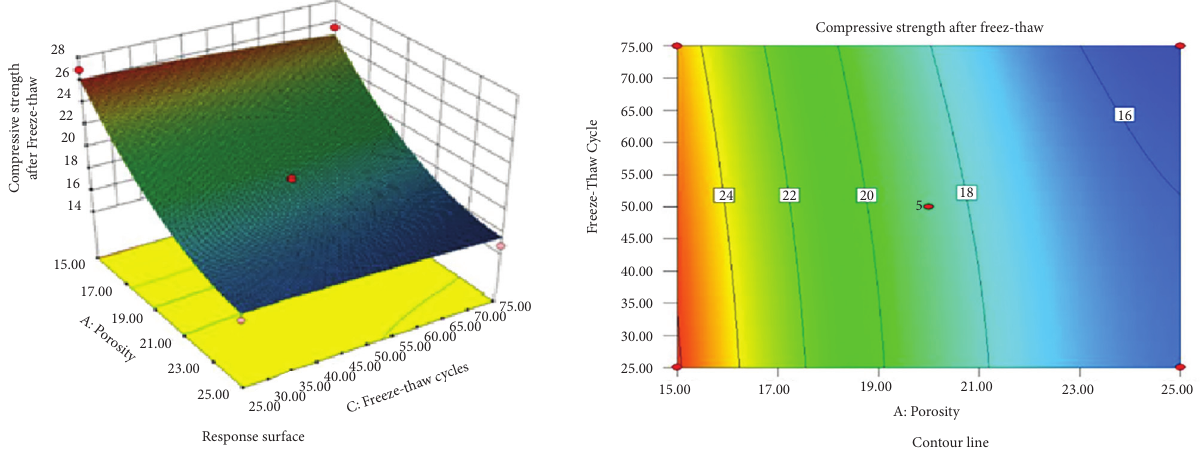
Figure 6: Influence of porosity A and freeze-thaw C on compressive strength after freeze-thaw.